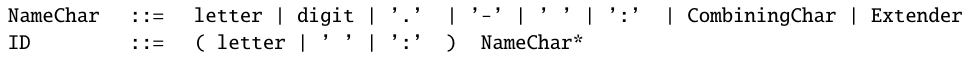
Figure 2.1: The definition of the type ID. The characters ( and ) are used for grouping, the character * indicates "zero or more times", and the character | indicates